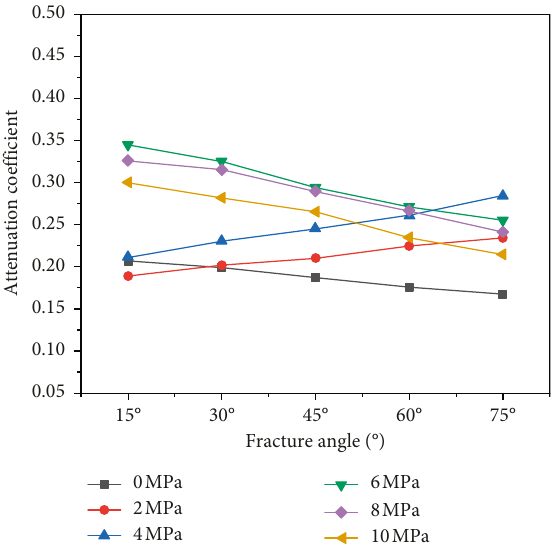
Figure 14: Variation of the stress attenuation coefficient with crack